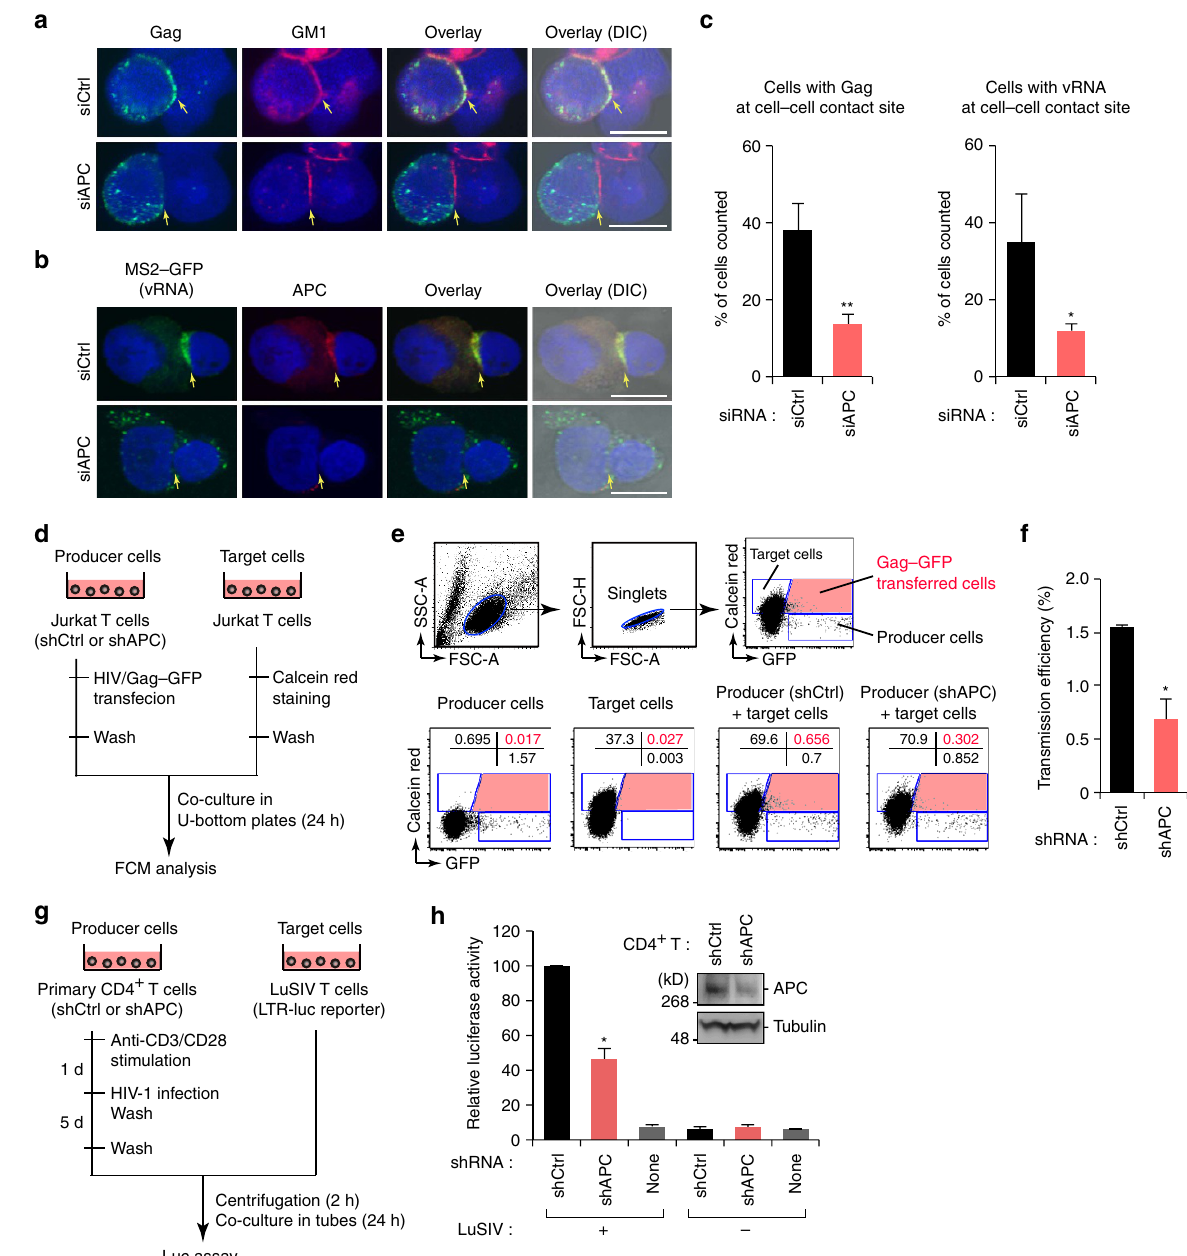
Figure 7 | APC regulates cell-to-cell viral transfer via virological synapses. ( a , c ) Confocal microscopic analysis of A3.01 cells expressing pNL4-3/Gag– EGFP and either control siRNA (siCtrl) or an APC-specific siRNA mix (siAPC). Cells were stained with Alexa594-conjugated Cholera Toxin Subunit B targeting cell surface GM1 ganglioside (red) and 4,6-diamidino-2-phenylindole (nuclei, blue). Scale bar, 10 m m. The arrows indicate the cell–cell contact site. The bar chart ( c , left) indicates the percentage of cells (at least 50 cells selected from random fields) that Gag was found at the cell–cell contact sites. ( b , c ) Confocal microscopic analysis of A3.01 cells co-expressing pNL4-3-pol-MS2x24, MS2–GFP and either siCtrl or siAPC. Cells were stained with anti-GFP (vRNA, green) and anti-APC (red). Scale bar, 10 m m. The arrows indicate the cell–cell contact site. The bar chart ( c , right) indicates the percentage of cells (at least 50 cells selected from random fields) that vRNA was found at the cell–cell contact sites. ( d – f ) Schematic representation of FACS-based cell-to-cell viral transfer assays used in this study. Jurkat cells stably expressing control shRNA (shCtrl) or APC-targeted shRNA (shAPC) were transfected with pNL4-3/Gag–EGFP, and were used as viral producer cells. Uninfected Jurkat cells stained with Calcein Red-Orange fluorescent dye were used as target cells. Two cell lines were co-cultured in a U-bottom plate for 24h, and fluorescence signals were then measured by flow cytometry. The transmission efficiency shown in f was calculated from the percentage of GFP þ cells among the Calcein-labelled cells by flow cytometry. Data were normalized with the number of virus producer cells. ( g , h ) Schematic representation of luciferase-based cell-to-cell viral spread assays used in this study. Primary CD4 þ Tcells stably expressing shCtrl or shAPC were infected with HIV-1 NL4-3 (50ng of p24 antigen) for 5 days, and were used as viral producer cells. LuSIV cells, a reporter cell line for HIV infection with Tat-mediated expression of luciferase, were used as target cells. These cells were co-cultured for 24h and subjected to luciferase activity ( h ). The expression of APC in cells is also shown. Full images for all immunoblots are provided in Supplementary Fig. 5. All graphs are presented as a mean ± s.d. ( n ¼ 3). * P o 0.05, ** P o 0.01, two-tailed unpaired t